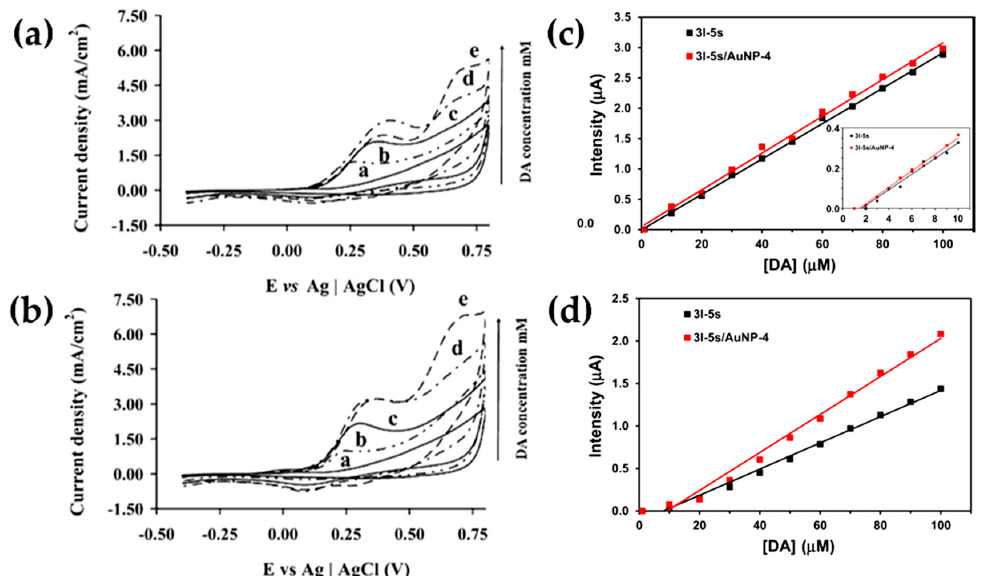
Figure 3. Cyclic voltammograms for the oxidation of ( a ) poly(N-methylpyrrole) (PNMPy)- and ( b ) PNMPy / gold nanoparticles (AuNPs)-modified carbon electrodes (GCEs) in the absence and presence of different dopamine (DA) concentrations (from 1 to 10 mM). Scan rate: 100 mV/s; initial and final potential: -0.40 V; reversal potential: +0.80 V. For each graphic, labels a-e refer to DA concentrations of 0, 1, 3, 6 and 10 mM, respectively; ( c ) calibration curve for DA concentrations ranging from 1 to 100 μ M (inset: from 1 to 10 μ M) in 0.1-M PBS and ( d ) calibration curve for DA concentrations ranging from 1 to 100 μ M in 0.1-M PBS with 200- μ M ascorbic acid and 100- μ M uric acid, acting as interferents at ), poly(3,4-ethylenedioxythiophene) (PEDOT)/PNMPy/PEDOT (3l-5s) and PEDOT/PNMPy/PEDOT/AuNPs (3l-5s/AuNP-4) electrodes. (a,b) Adapted with permission from reference [68], Copyright © 2011 American Chemical Society and (c,d) from reference [69], Copyright © 2014 American Chemical Society.